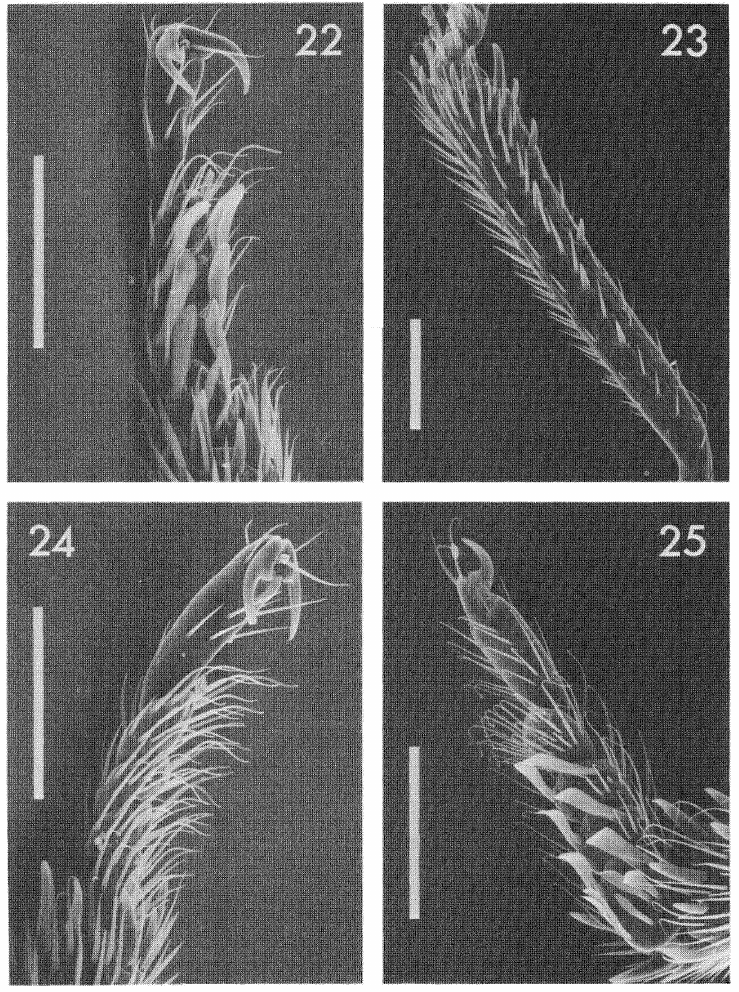
Figs. 22-25. Glypholoma spp., prolegs. 22-24. G. pustuliferum; 22, male tarsus, oblique ventral view; 23, male left tibia, posterior view; 24, female tarsus, oblique ventral view. 25. G. rotundulum, male tarsus, oblique ventral view. Scale lines 0.1